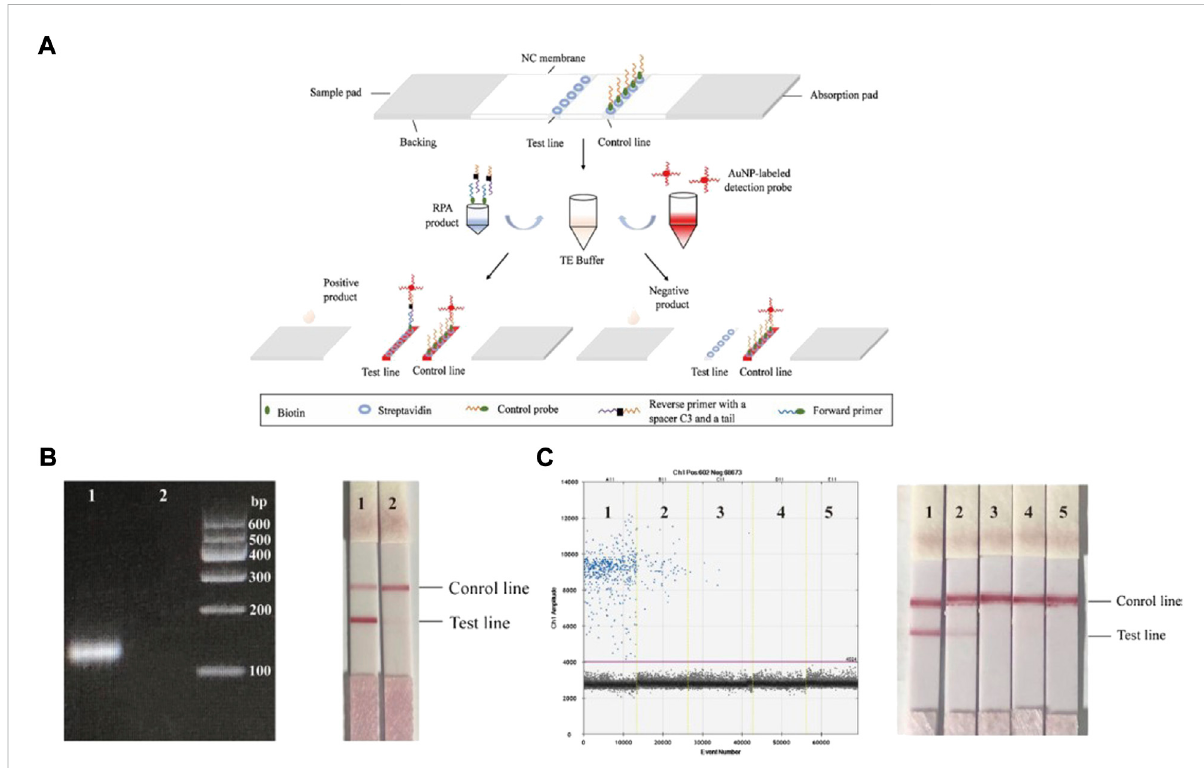
FIGURE 5 (A) The principle of lateral fl ow gene assay. The RPA product and the AuNP-labeled detection probe were added to TE buffer, and then the mixed droplets were added to the sample pad of the strip. In the presence of positive products, there will be two red lines on both the test line and control line.Inthepresenceofnegativeproducts, therewill beonlyone redlineon thecontrolline. (B) Thedetection resultofsample,Lane 1:target DNA; Lane 2: double-distilled H 2 O. (C) A series of tenfold DNA diluents from 10 1 to 10 4 extracted from blood infected with ASFV were used